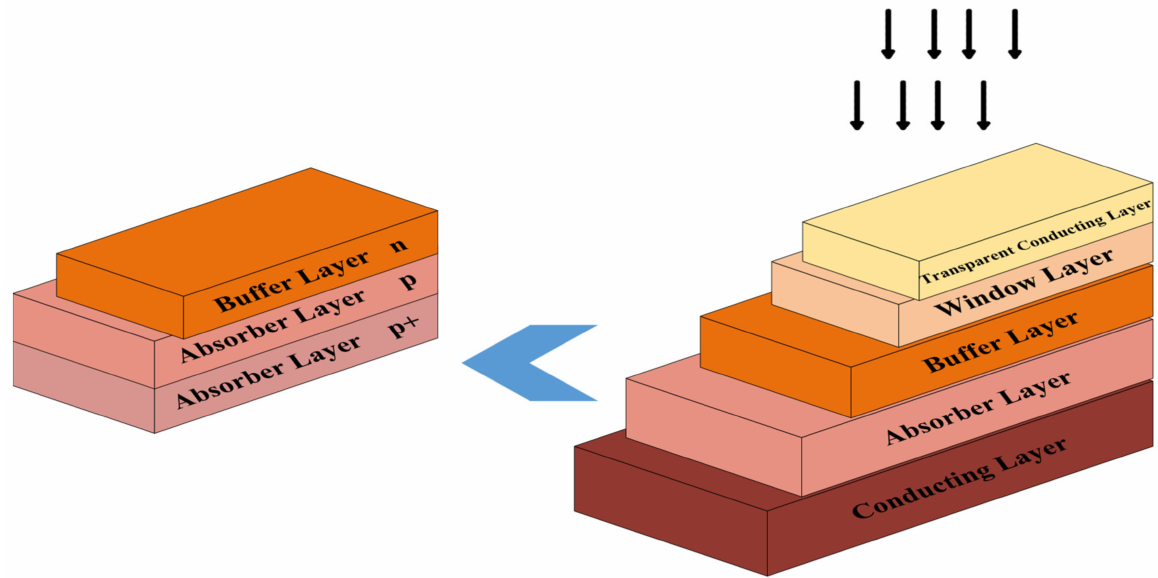
Figure 1. Schematic of the proposed CZTSe-based solar cell